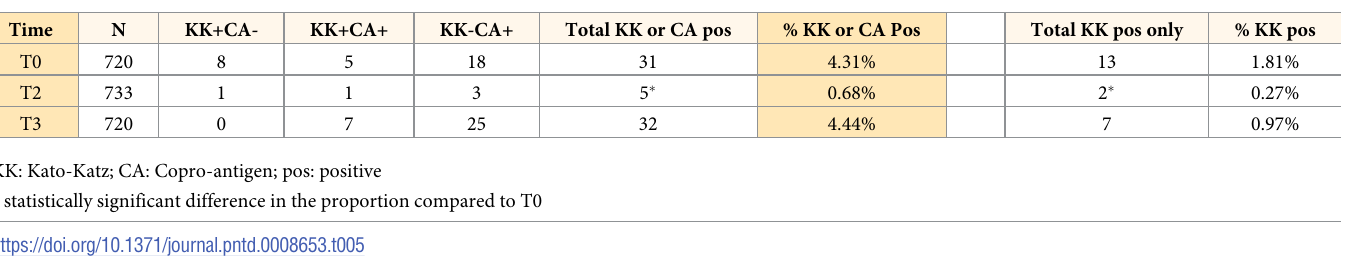
Table 5. Results of faecal testing for taeniasis during a pilot control program for T . solium in Madagascar. Results of Kato-Katz and copro-antigen tests on faecal sam- ples before (T0), after the final round of MDA (T2) of the 3-year pilot project, and one year later (T3). Results are shown for the 15 villages matched between T0, T2 and